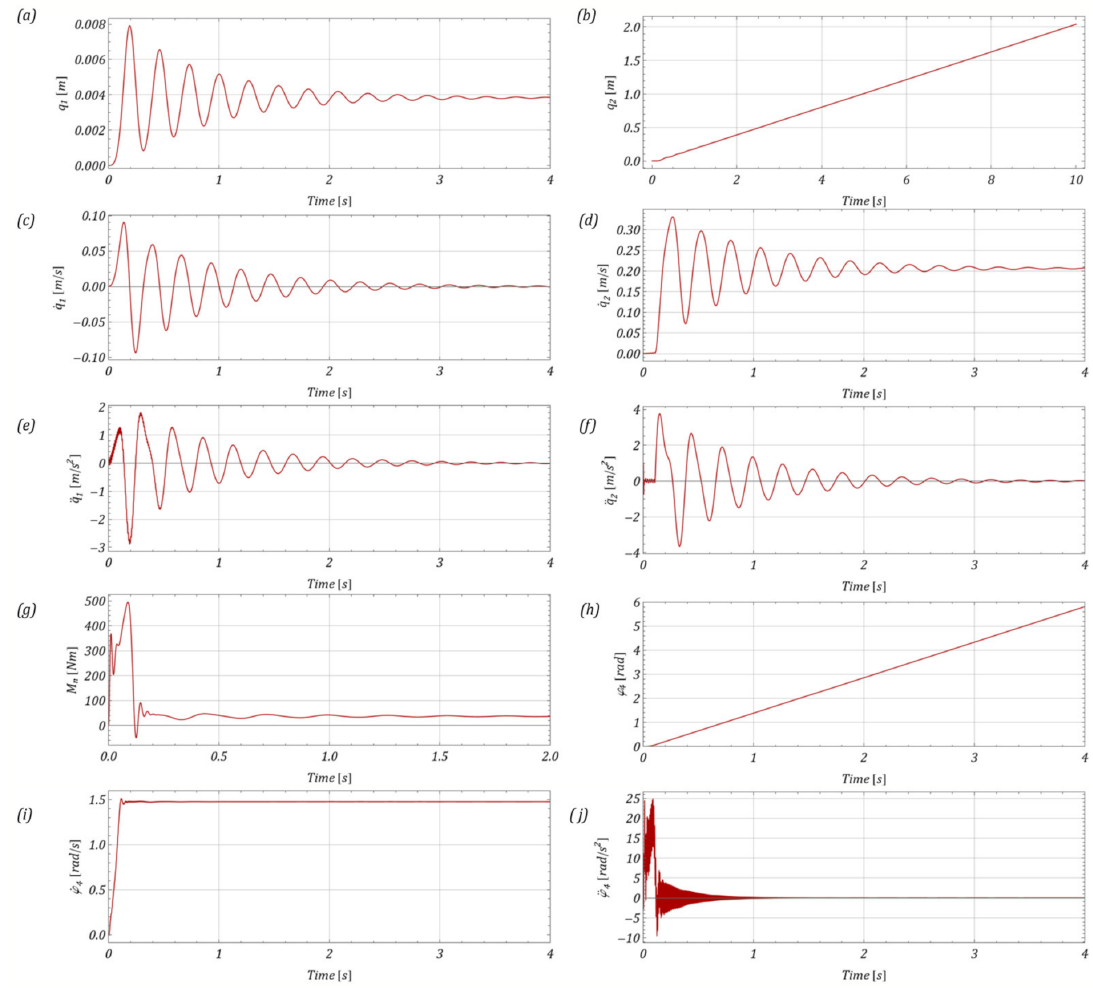
Figure 8. Time series of the dynamic selected variables of the hoisting model, ( a ) crane girder vibration amplitude as a function of time, ( b ) load displacement amplitude as a function of time, ( c ) speed of the crane girder center as a function of time, ( d ) load movement speed as a function of time, ( e ) acceleration of the crane girder center as a function of time, ( f ) acceleration of a moving load as a function of time, ( g ) motor drive torque as a function of time, ( h ) angle of rotation of the lower sheave as a function of time, ( i ) angular velocity of the lower block sheave as a function of time, ( j ) angular acceleration of the lower pulley as a function of